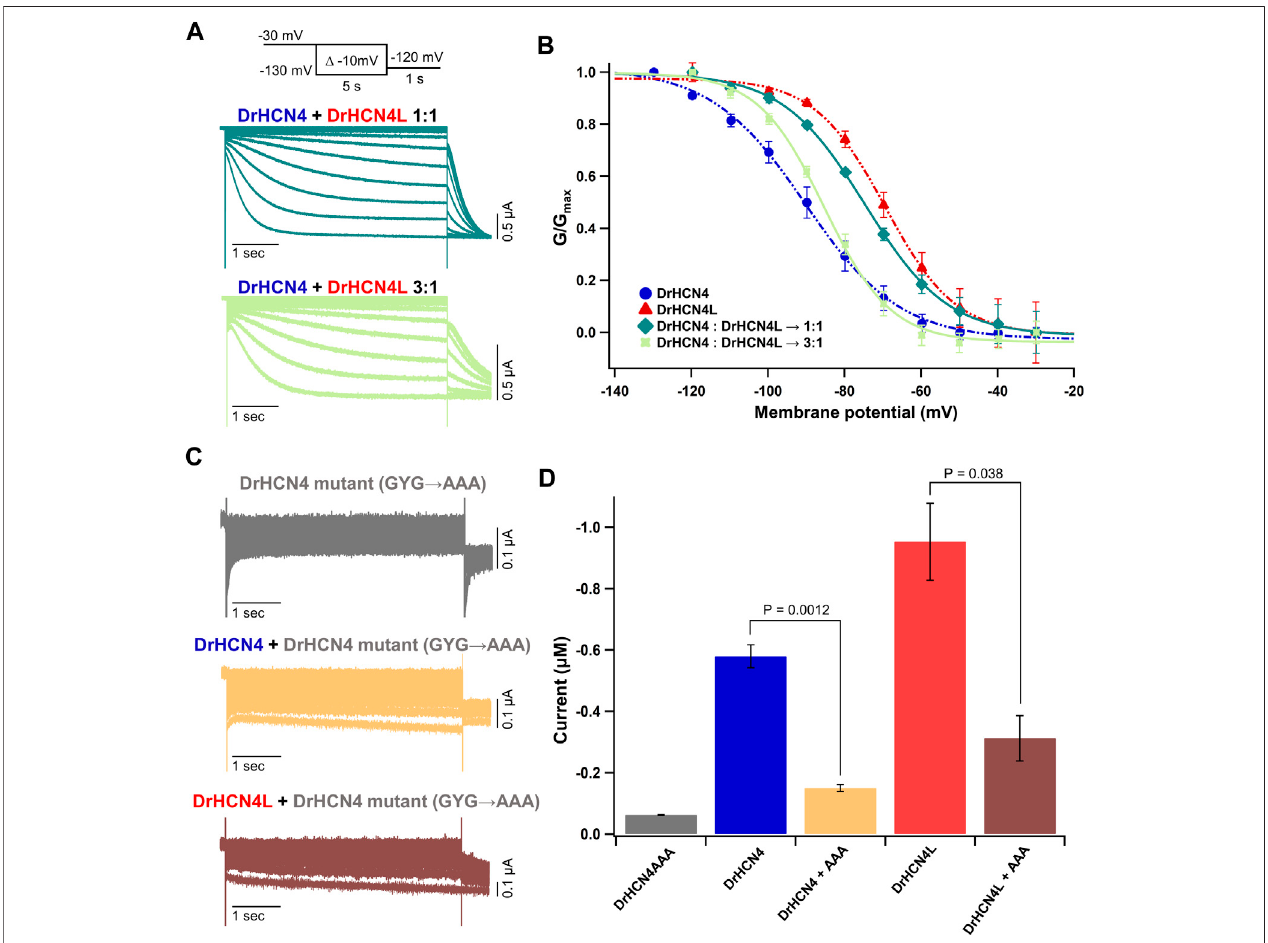
FIGURE 3 | DrHCN4 and DrHCN4L can form a heterotetrametric channel. (A) Representative current traces of a mixture of DrHCN4 and DrHCN4L mRNA. The mixed mRNA concentrations were 1:1 (green) and 3:1 (light green). Membrane potential was varied from − 30 mV to − 130 mV in 10-mV decrements and held for 5 s at each potential. The inset shows the stimulation protocol. (B) Activation curves of the mixed channels of DrHCN4 and DrHCN4L. The mixed mRNA concentrations were 1:1 (green) and 3:1 (light green). Blue and red curves are the activation curves of DrHCN4 and DrHCN4L, respectively. The Boltzmann function fi ts the activation curves ( n = 5). All data are from the same batch of oocytes. Therefore, the data sets of DrHCN4 and DrHCN4L are different from the datasets used in Figures 1 , 2 . (C) Representative current traces of a dominant-negative mutantwith or without wild-type DrHCN4 or DrHCN4L. From top to bottom: DrHCN4 mutant (DrHCN4AAA) only, DrHCN4 (wild-type) + DrHCN4AAA, DrHCN4L (wild-type) + DrHCN4AAA. Wild-type and mutant cRNAs were mixed in a 1:1 ratio with 5 ng each. (D) Averaged current amplitudes at − 100 mV were plotted as bar graphs [ n = 5 for each except DrHCN4AAA alone ( n =